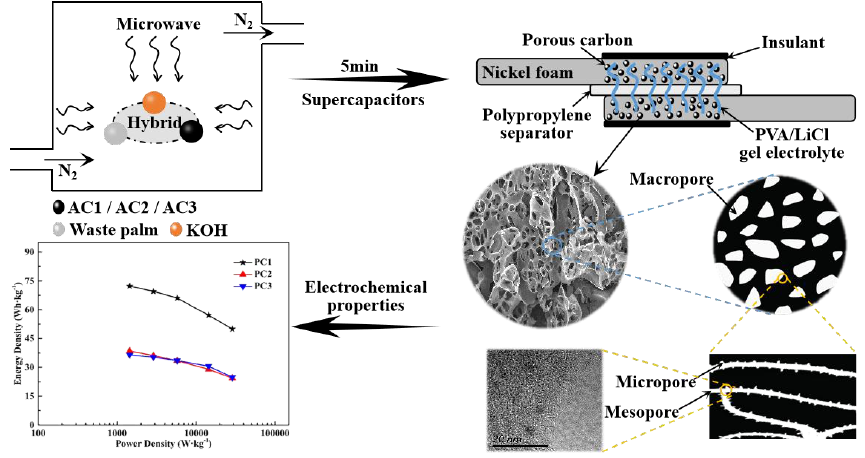
Figure 1. Schematic of the synthesis process for the solid-state symmetric supercapacitor. AC: activated carbon, PVA: polyvinyl alcohol.